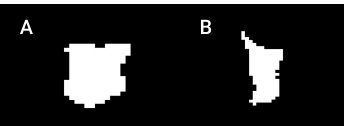
Figure 3. Root canal volume after segmentation. Cone beam computed tomography (A); micro-computed tomography